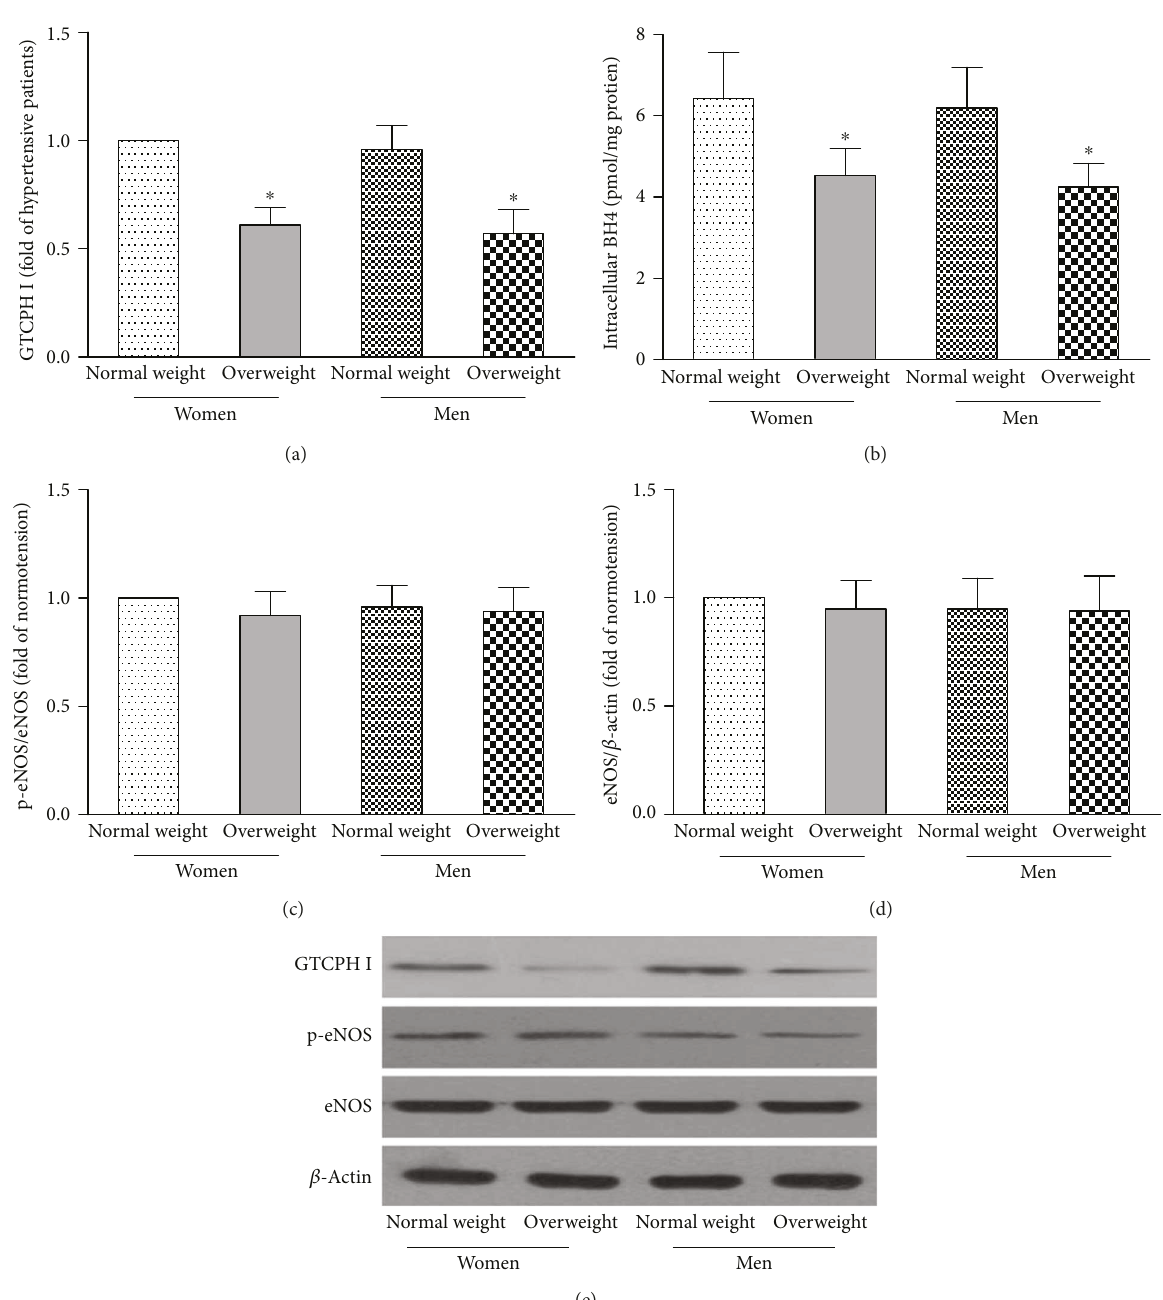
Figure 6: The CTCPH I/BH4 pathway and the phosphorylation of eNOS in circulating EPCs. The levels of GTCPH I (a) and intracellular BH4 (b) in EPCs were lower in overweight men and postmenopausal women than in normal weight men and postmenopausal women. There was no di ff erence in the level of GTCPH I (a) or intracellular BH4 (b) in EPCs between normal weight and overweight postmenopausal women and men. No signi fi cant di ff erence was found in either eNOS phosphorylation (c) or eNOS protein expression (d) in EPCs among the four groups. Representative photographs and quantitative analyses of GTCPH I and p-eNOS protein expression in cultured EPCs (e). ∗ p < 0 05 versus normal